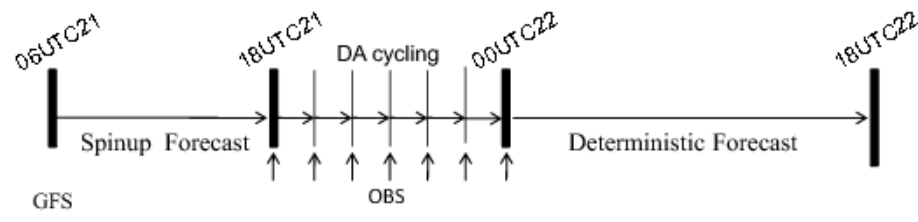
Figure 2. The flowchart for the analyses/forecast cycling experiments.